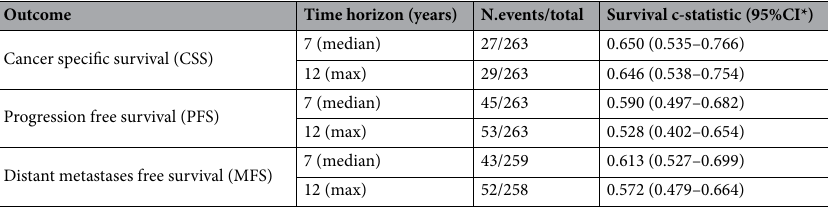
Table 4. Prognostic accuracy of each outcome-specific weighted miRNA score at median and maximum time horizons. *95% confidence interval after 1000 perturbation-resamplings of the data.